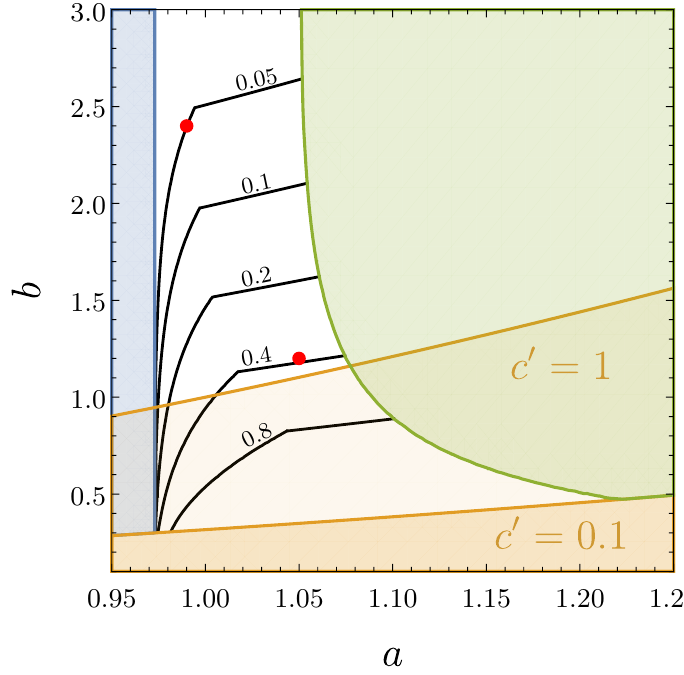
Figure 2 . Allowed part of parameter space for our potential (3.1) subject to the RdSC (lower shaded), w ( z ) and (cid:10) (cid:3) (upper right shaded) and (cid:10) (cid:3) (left shaded) constraints. Contours show the maximum allowed misalignment of the (cid:12)eld (cid:30)=M Pl from the top of the potential. The contour segment to the left of the kink is constrained by (cid:10) (cid:3) , whereas the segment to the right is constrained by w ( z ). Red dots indicate benchmark examples plotted in (cid:12)gures 3 and 4. We show regions excluded by the RdSC (orange) for c 0 = 0 : 1 and c 0 = 1 for